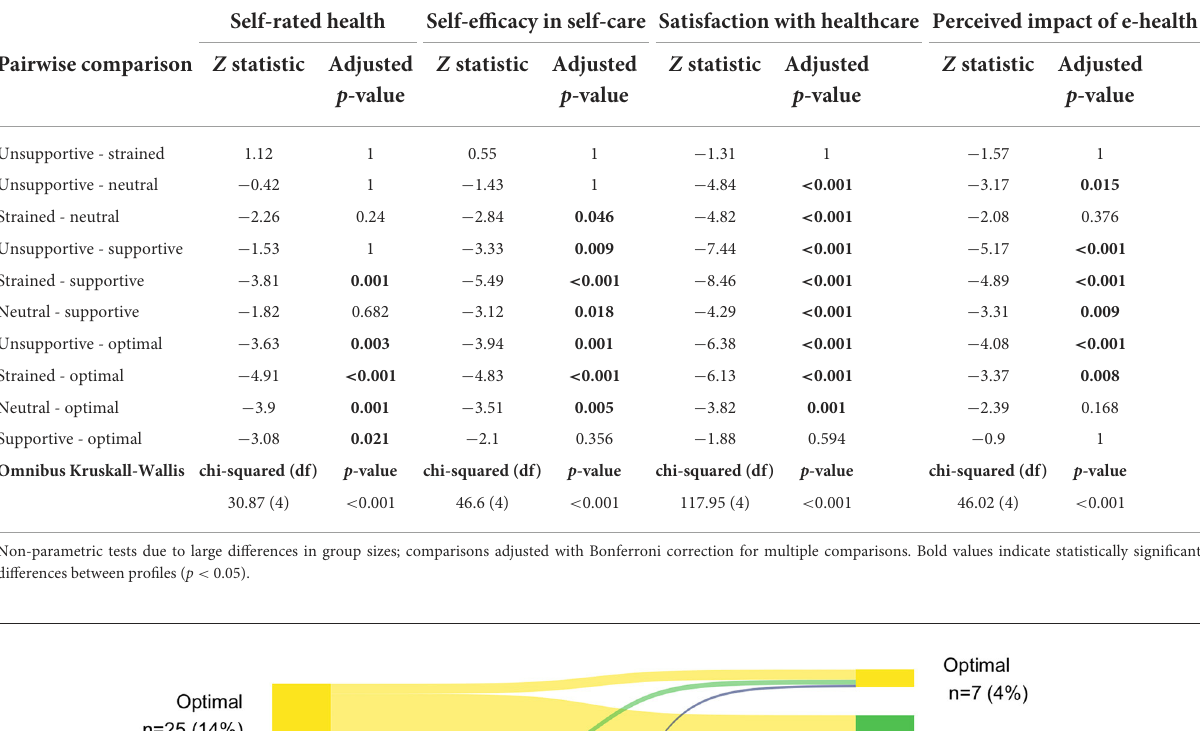
TABLE 10 Pairwise comparisons of exogenous variables between latent profiles at T2 ( N = 180).